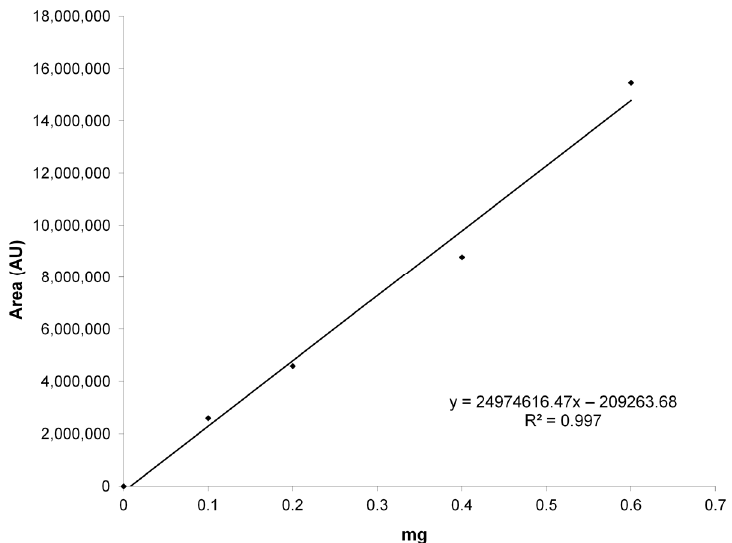
Figure 9. CM-glucan calibration curve. The curve was obtained by plotting the CM-glucan amount injected onto the HPLC and its peak area at 220 nm.